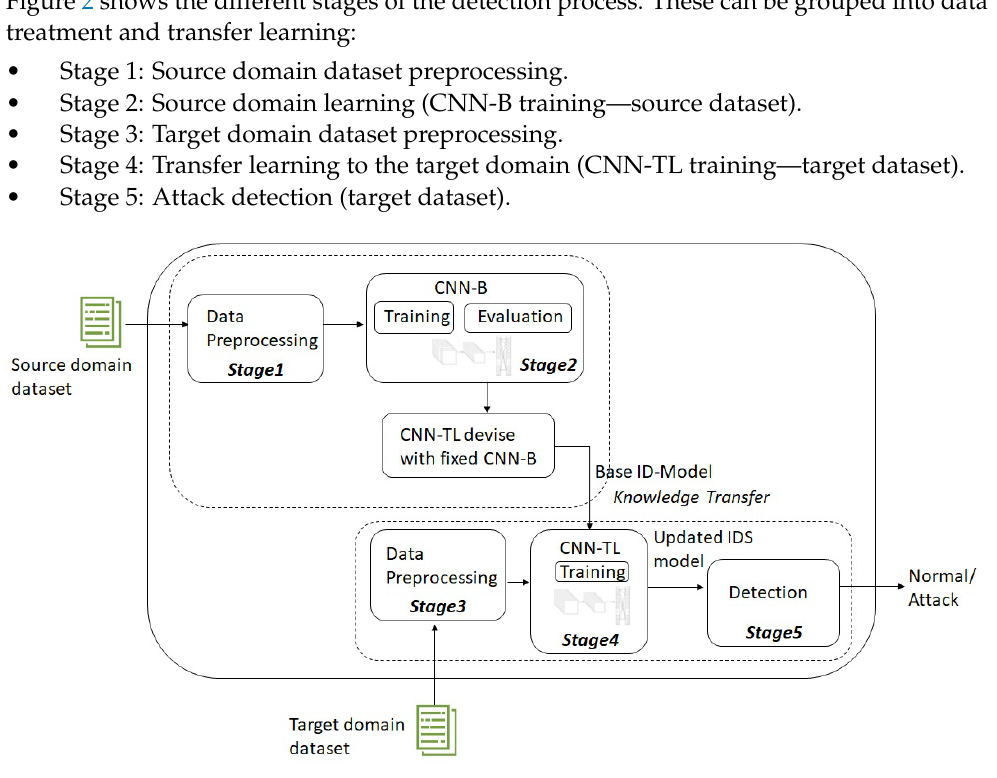
Figure 2. Overall structure of the proposed intrusion detection